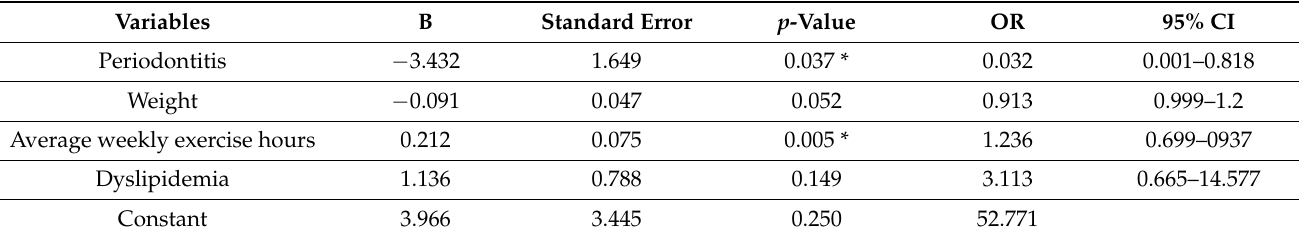
Table 8. Results of the binary logistic regression analysis to estimate the association between different variables and those who suffer from